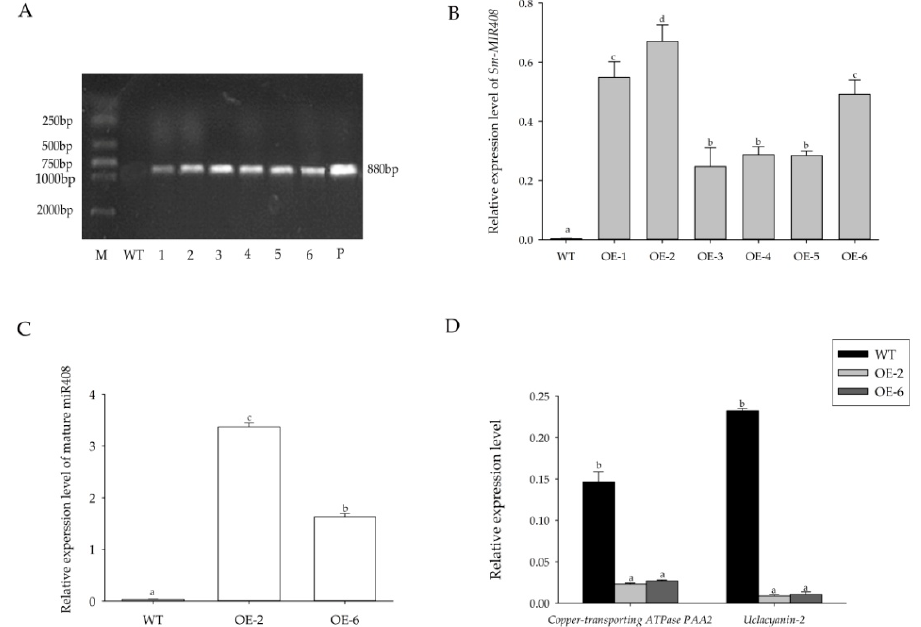
Figure 2. Detection of Sm-miR408 overexpressing (OE) transgenic lines. ( A ) PCR amplification product of 35S promoter from transgenic Nicotiana benthamiana genomic DNA (gDNA). Lanes: M, DL2000 DNA marker; WT, wild-type plants as negative control; 1-6, different transgenic lines; P, plasmids as positive control. ( B , C ) Relative expression levels of Sm-MIR408 ( B ) and mature miR408 ( C ) in transgenic lines and WT. ( D ) Relative expression levels of copper-transporting ATPase PAA2 and uclacyanin-2 in transgenic lines and WT. The data represent means ± SD of three independent experiments. Significant differences were determined using Duncan’s multiple range test (indicated by different letters at p <